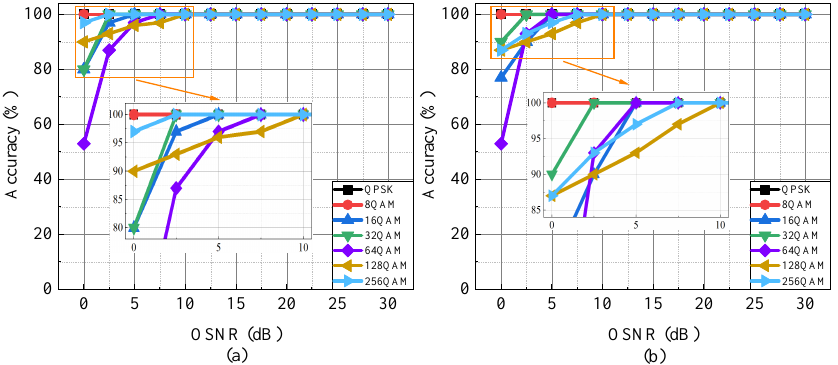
Figure 7. Comparison of seven types of signal identification accuracy. The fiber distance is set as ( a ) 80 km, ( b ) 120